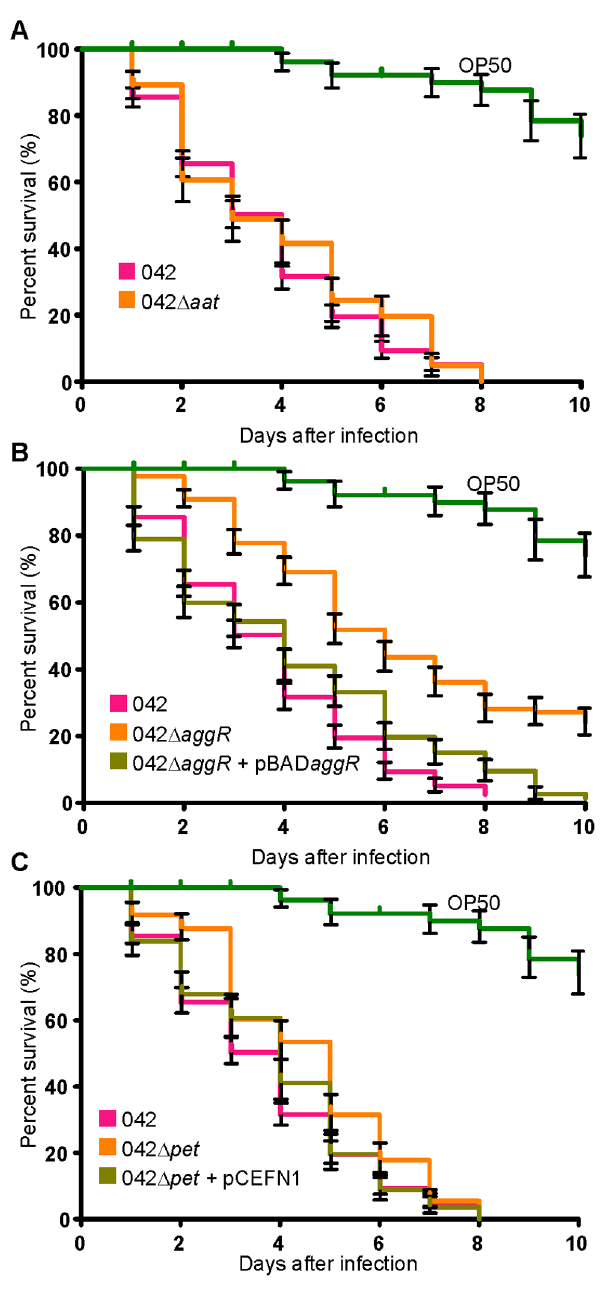
Figure 4. Deleting virulence factors from EAEC 042 slows C. elegans killing. Nematode slow-kill virulence assays on NGM agar. The ability of EAEC 042, (A) 042 D aat, (B) 042 D aggR, 042 D aggR + pBAD aggR , (C) 042 D pet and 042 D pet + pCEFN1 to kill the nematode worm C. elegans was examined over a 10 day period. Error bars represent + / 2 standard error. The 042 D aggR (LT 50 : 5.2, P , 0.001) and 042 D pet (LT 50 : 4.29, P , 0.05) strains had significantly higher LT 50 than the 042 wildtype (LT 50 : 3.1). Complementation of these genes via pBAD aggR (LT 50 : 3.4) or pCEFN1 (LT 50 : 3.6) restored the LT 50 to wildtype levels. The 042 D aat strain had an LT 50 similar to wildtype (LT 50 : 2.9).